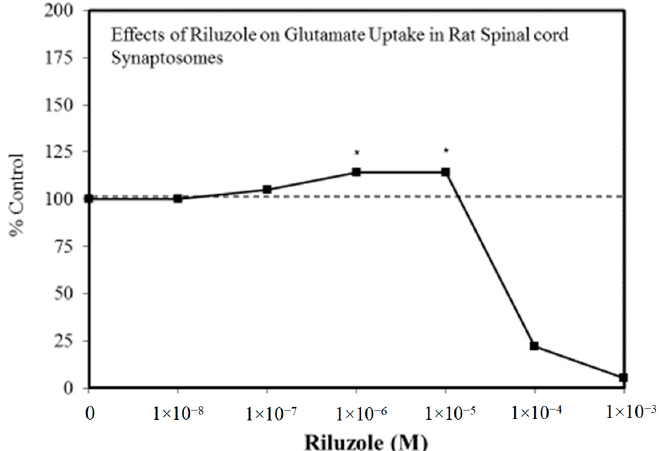
Figure 5. Effects of riluzole on glutamate uptake in rat spinal cord synaptosomes (Source: Frizzo et al. [60]).